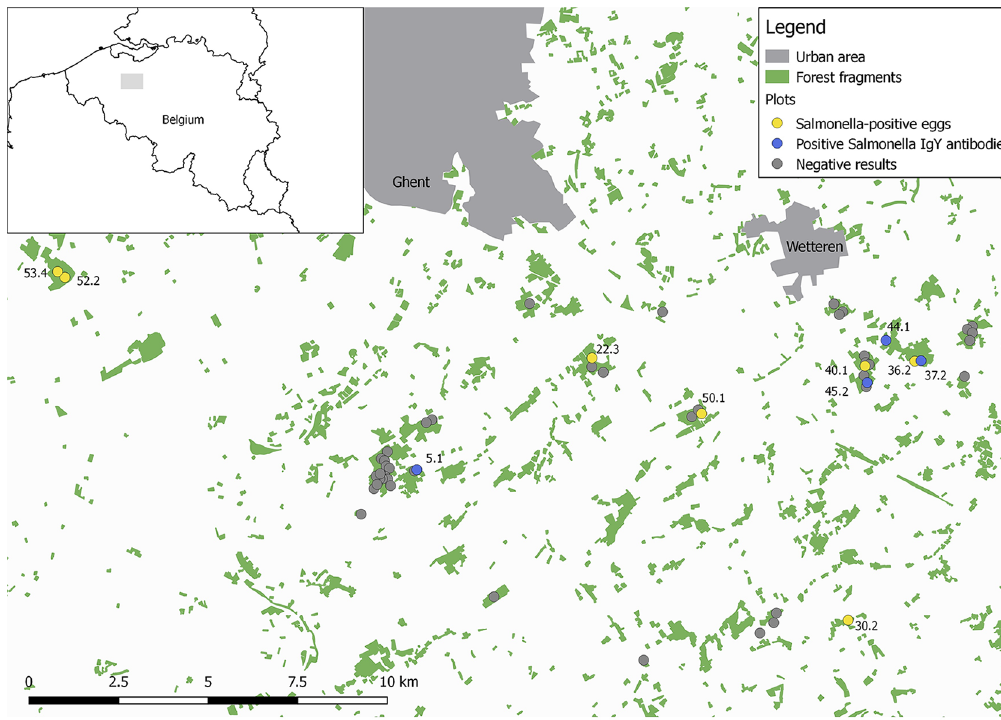
Fig 1. Map of the study plots showing the distribution of Salmonella Typhimurium. Shownare the study plots used to investigate Salmonella Typhimurium presence in blue and great tit nest boxes. Negativeplots are indicatedby grey dots, plots where Salmonella was found on the eggshellare represented by yellow dots and plots with nestlings carrying Salmonella IgY antibodiesare depictedby blue